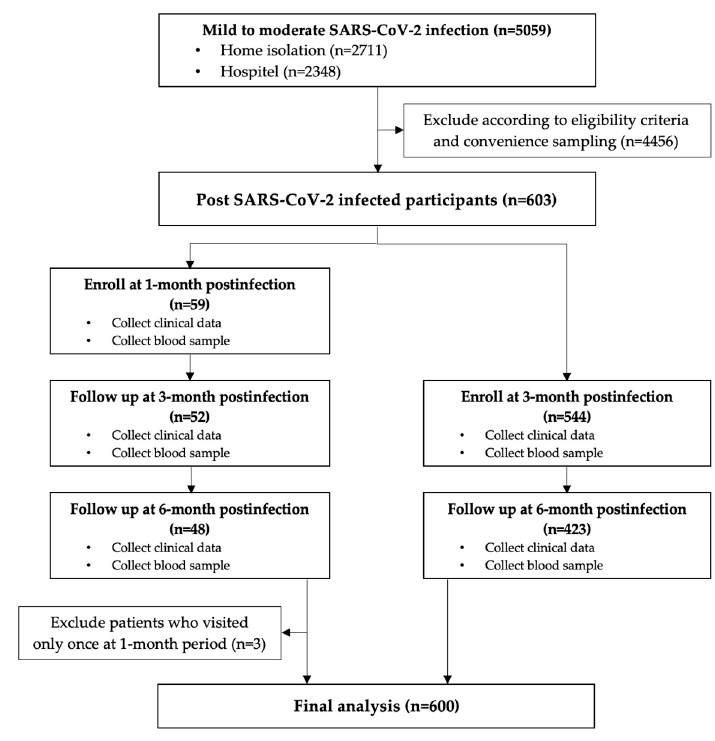
Figure 1. Flowchart of patient enrollment.